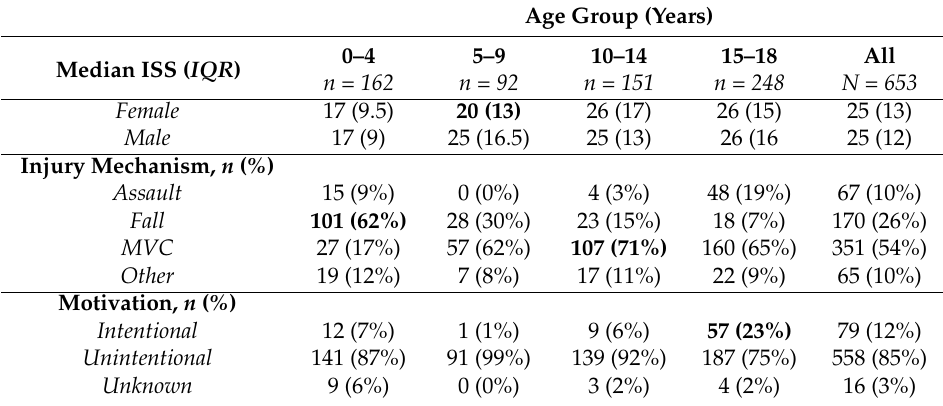
Table 2. Shows pediatric TBI by age group, gender, injury mechanism and intent. Injuries from falls are the major cause of injuries for those aged 0–4. Intentional injuries and injuries from assault are the number one cause of injuries for those